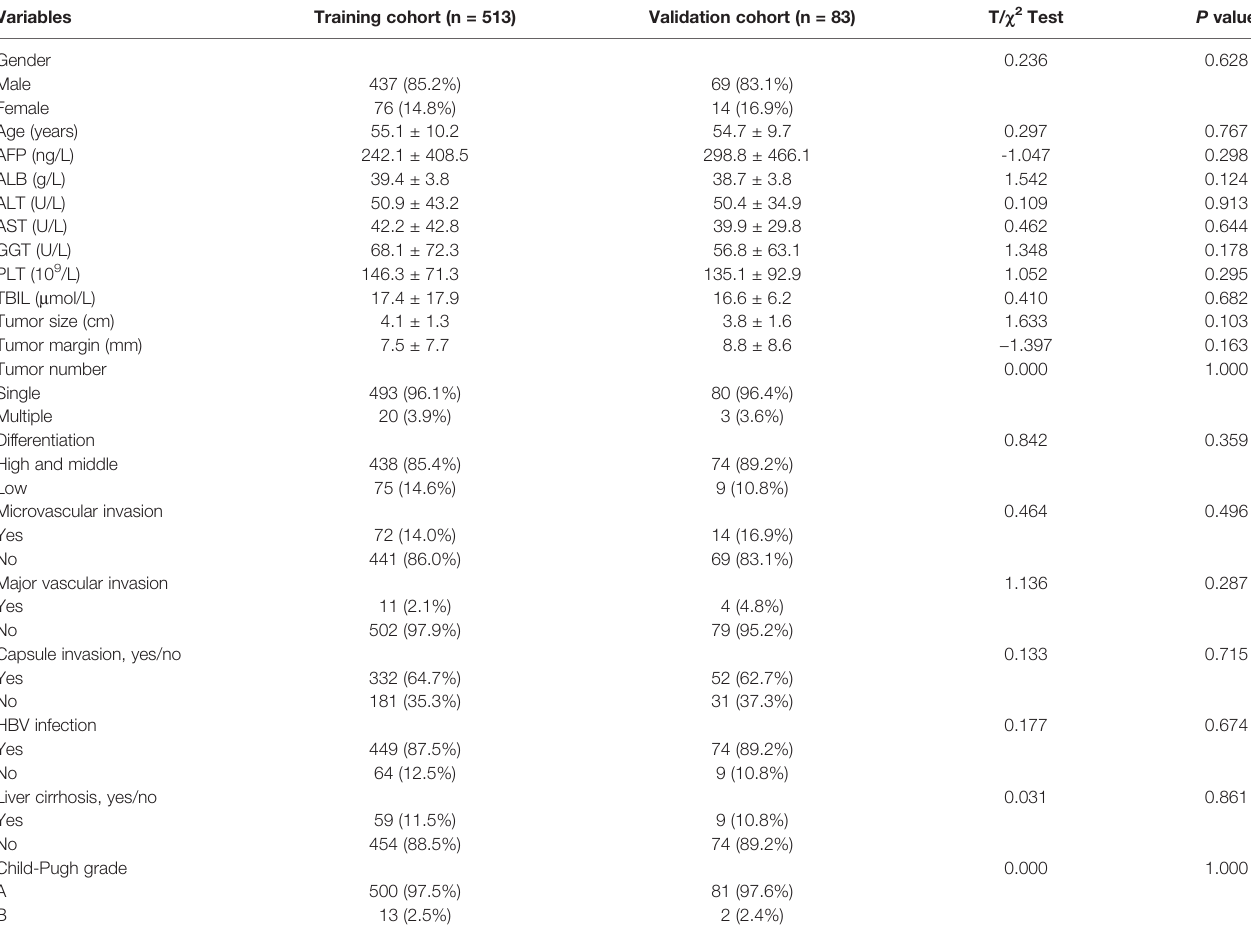
TABLE 1 | Basic characteristics of HCC patients in the training and validation